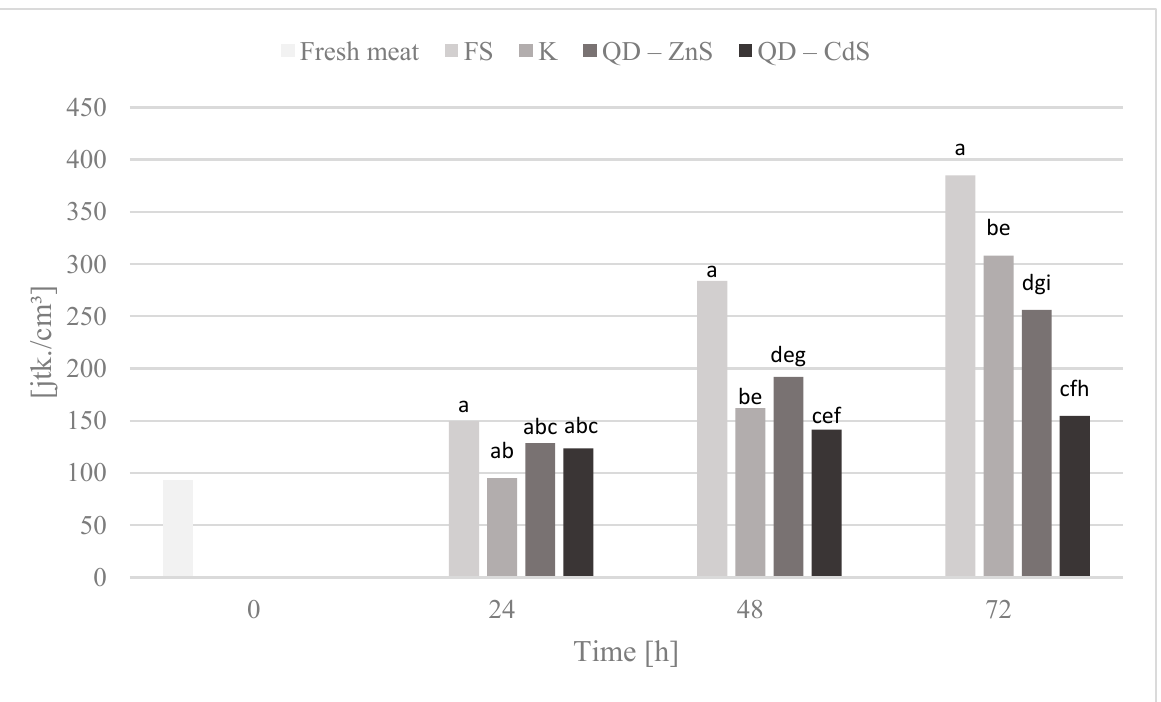
Materials 2021 , 14 , x FOR PEER REVIEW